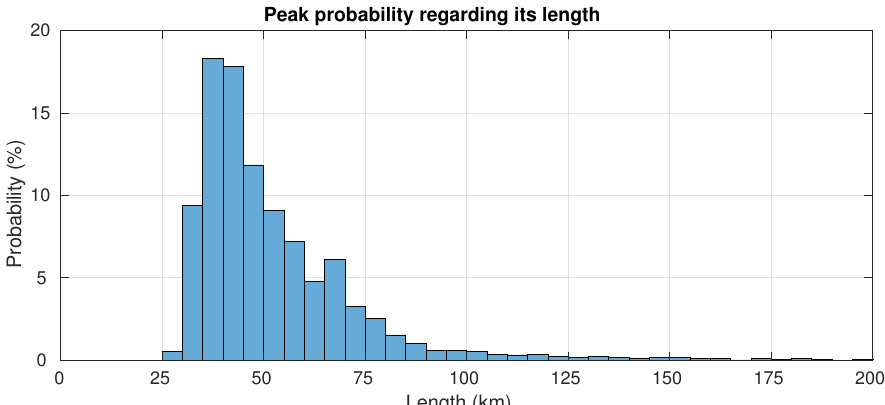
Figure 21. Histogram of bubble length during 25 equally spaced days in 2017 representing the probability in bins of 5 km with a total number of samples of around